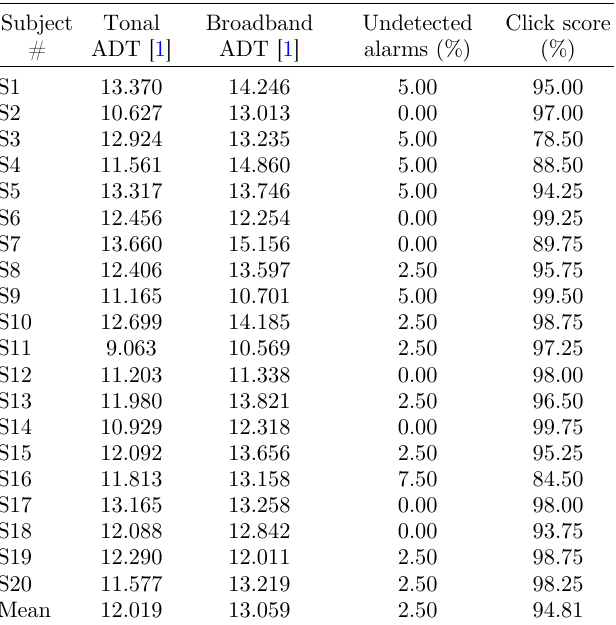
Table 3. Average detection times of reversing alarms using binaural reproduction with